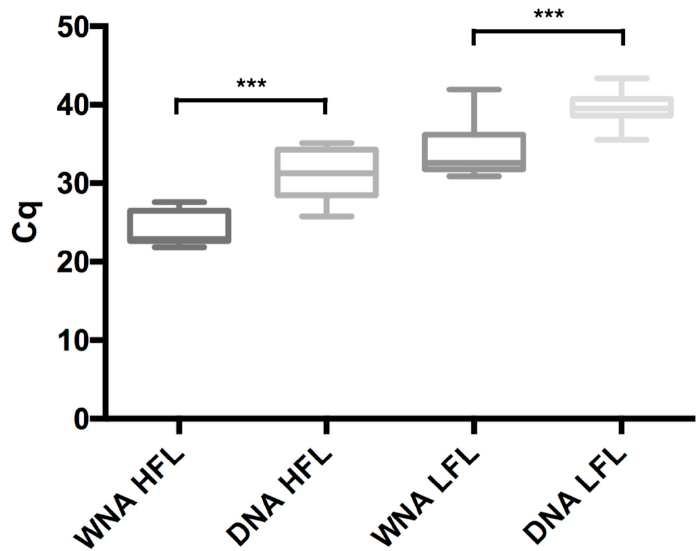
Figure 1. Comparison of quantitative cycle ( Cq ) values independently of mixes and thermocyclers between qPCR method targeting WNA or DNA for high (pure extract, HFL) and low (1:1000 dilution, LFL) fungal load. WNA: whole nucleic acid; Cq : quantitative cycle. *** p < 0.0001.